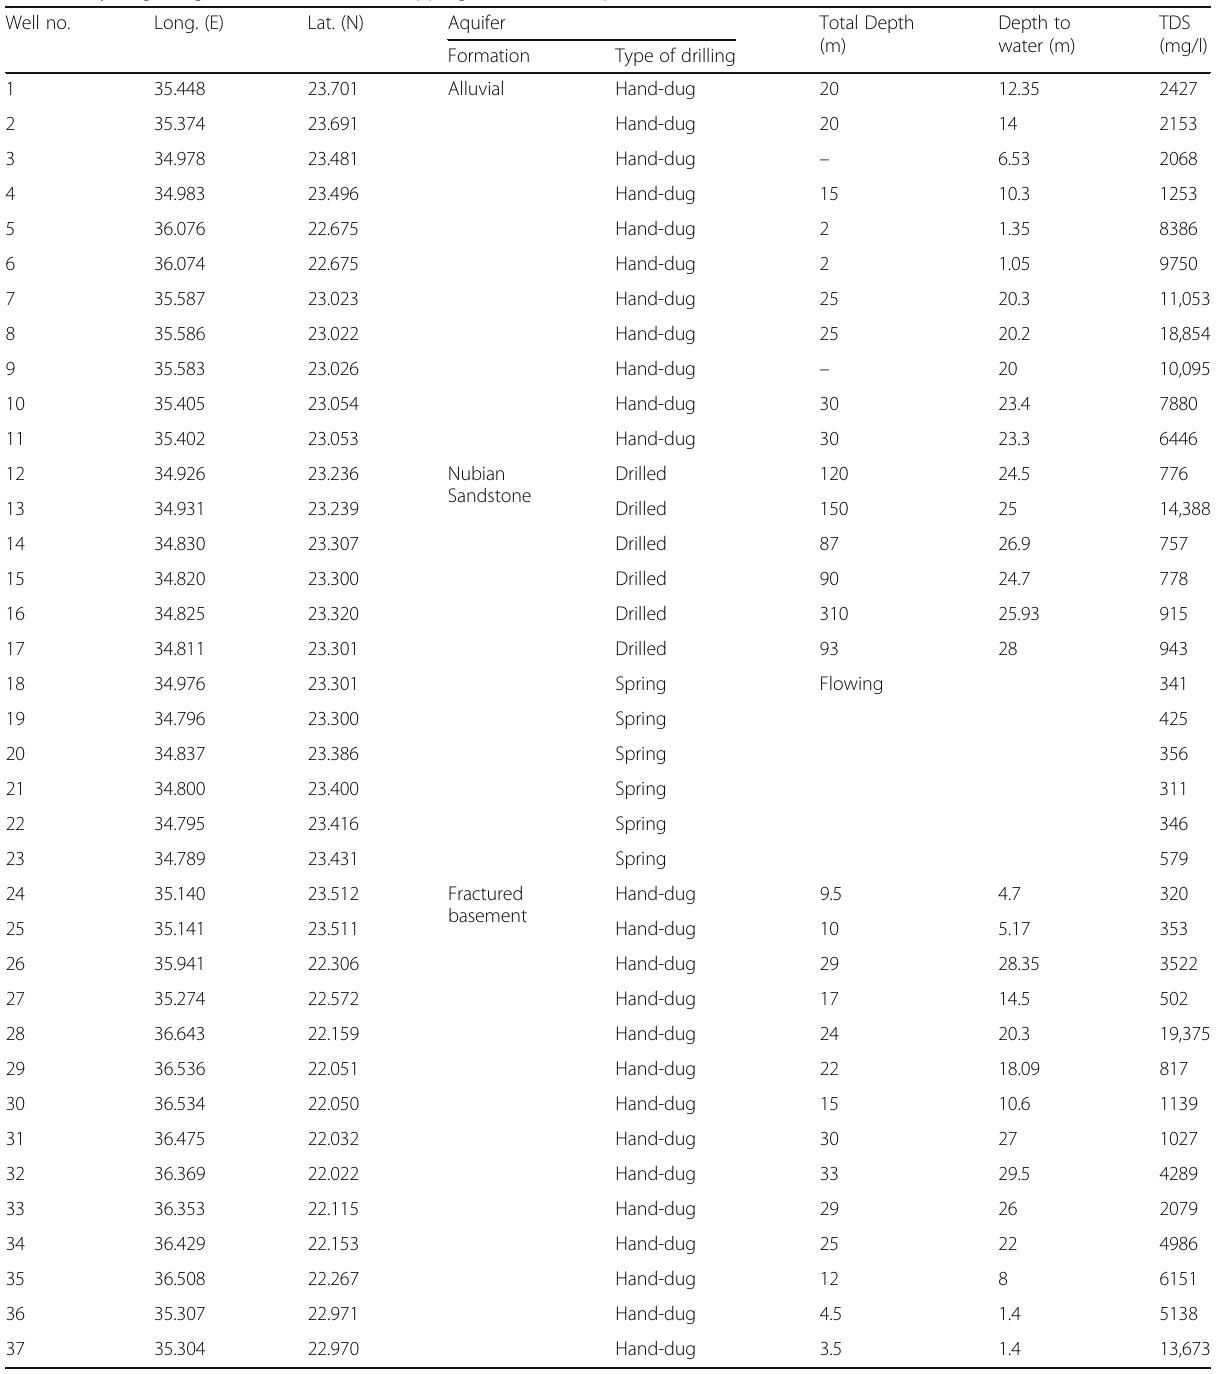
Table 1 Hydrogeological data of the wells tapping the studied aquifers Well